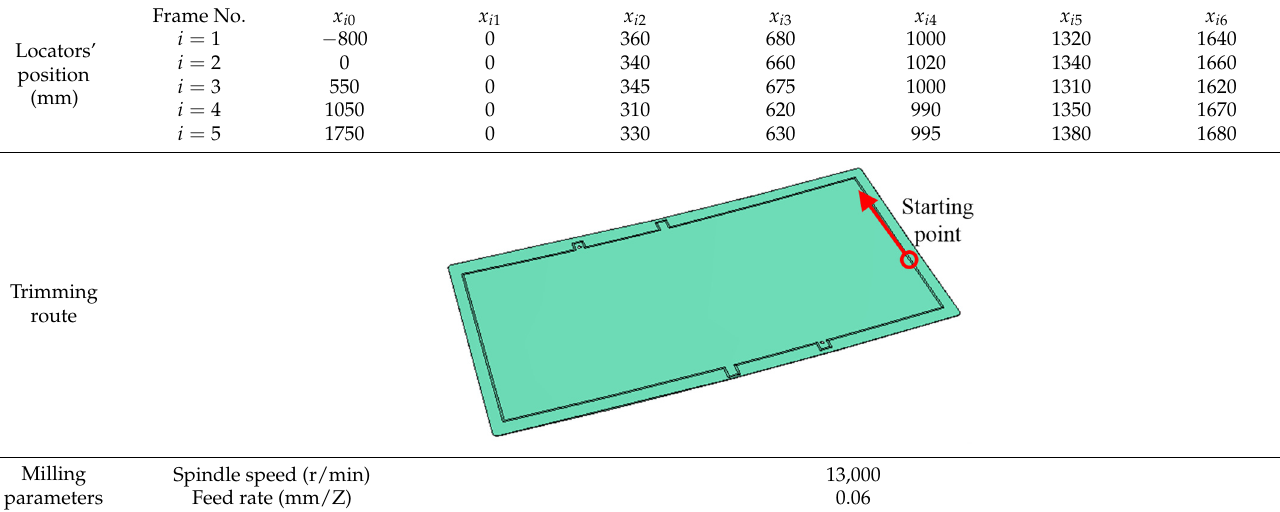
Table 2. Optimized process scheme.